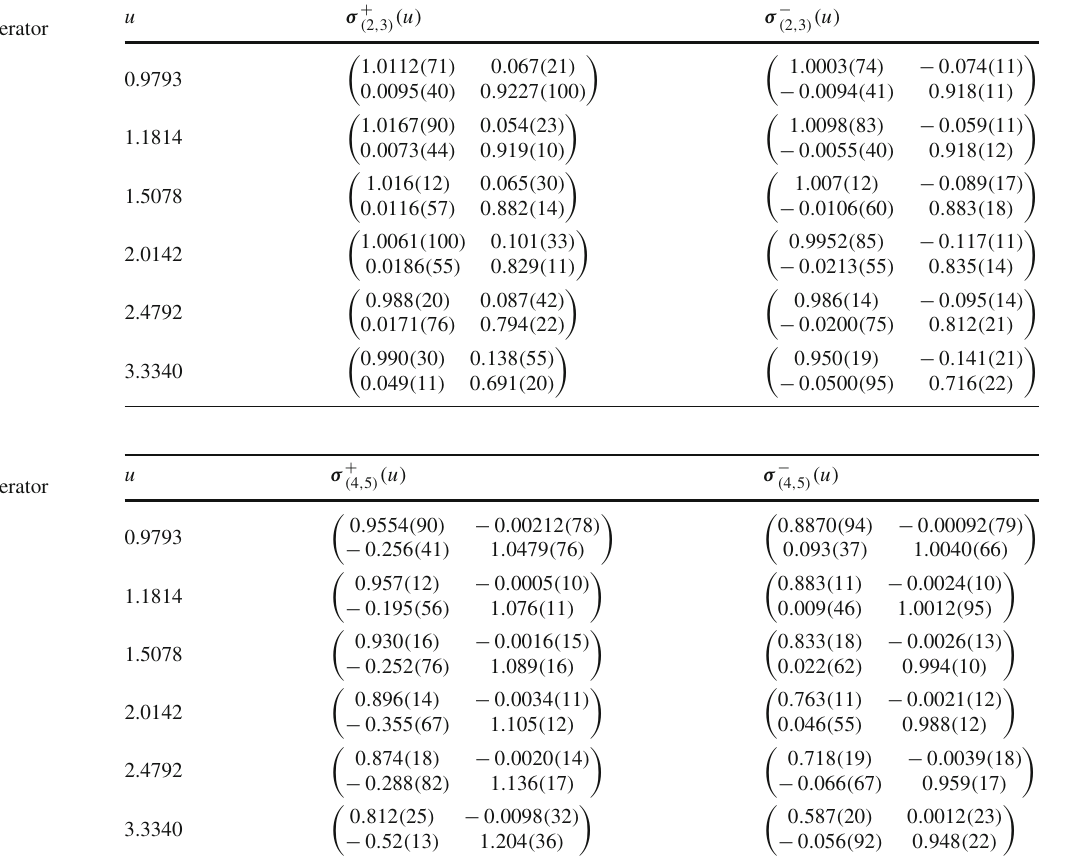
matrix-SSFs for the operator bases { Q ±